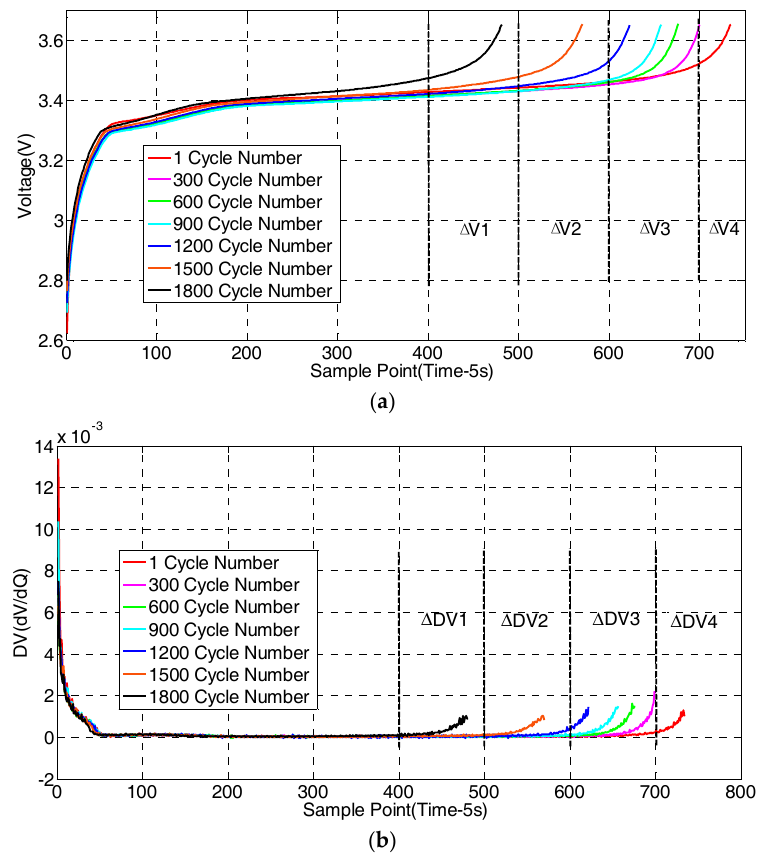
Figure 8. The SVM training data: ( a ) the specific delta V data; and ( b ) the specific delta DV data.